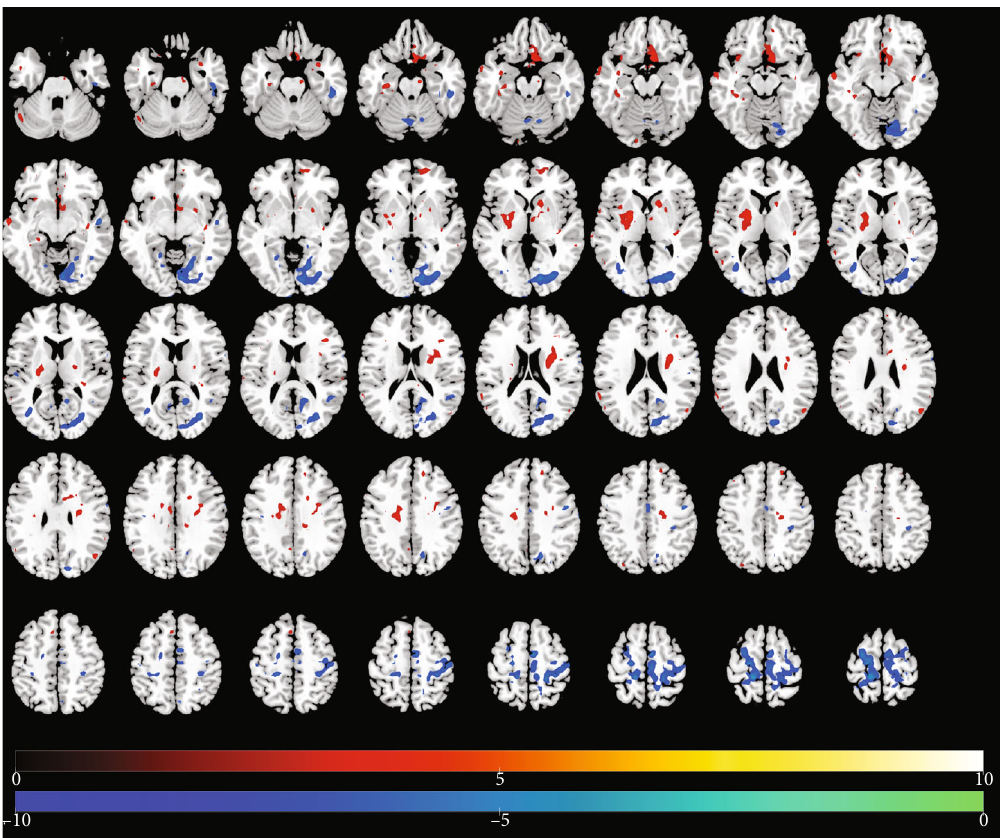
Figure 2: Changes in regional brain activity 6 months after traumatic amputation by using rs-fMRI. Di ff erences in the magnitude of ALFF between the same upper-limb amputee patients and control subjects. Same conventions as in Figure